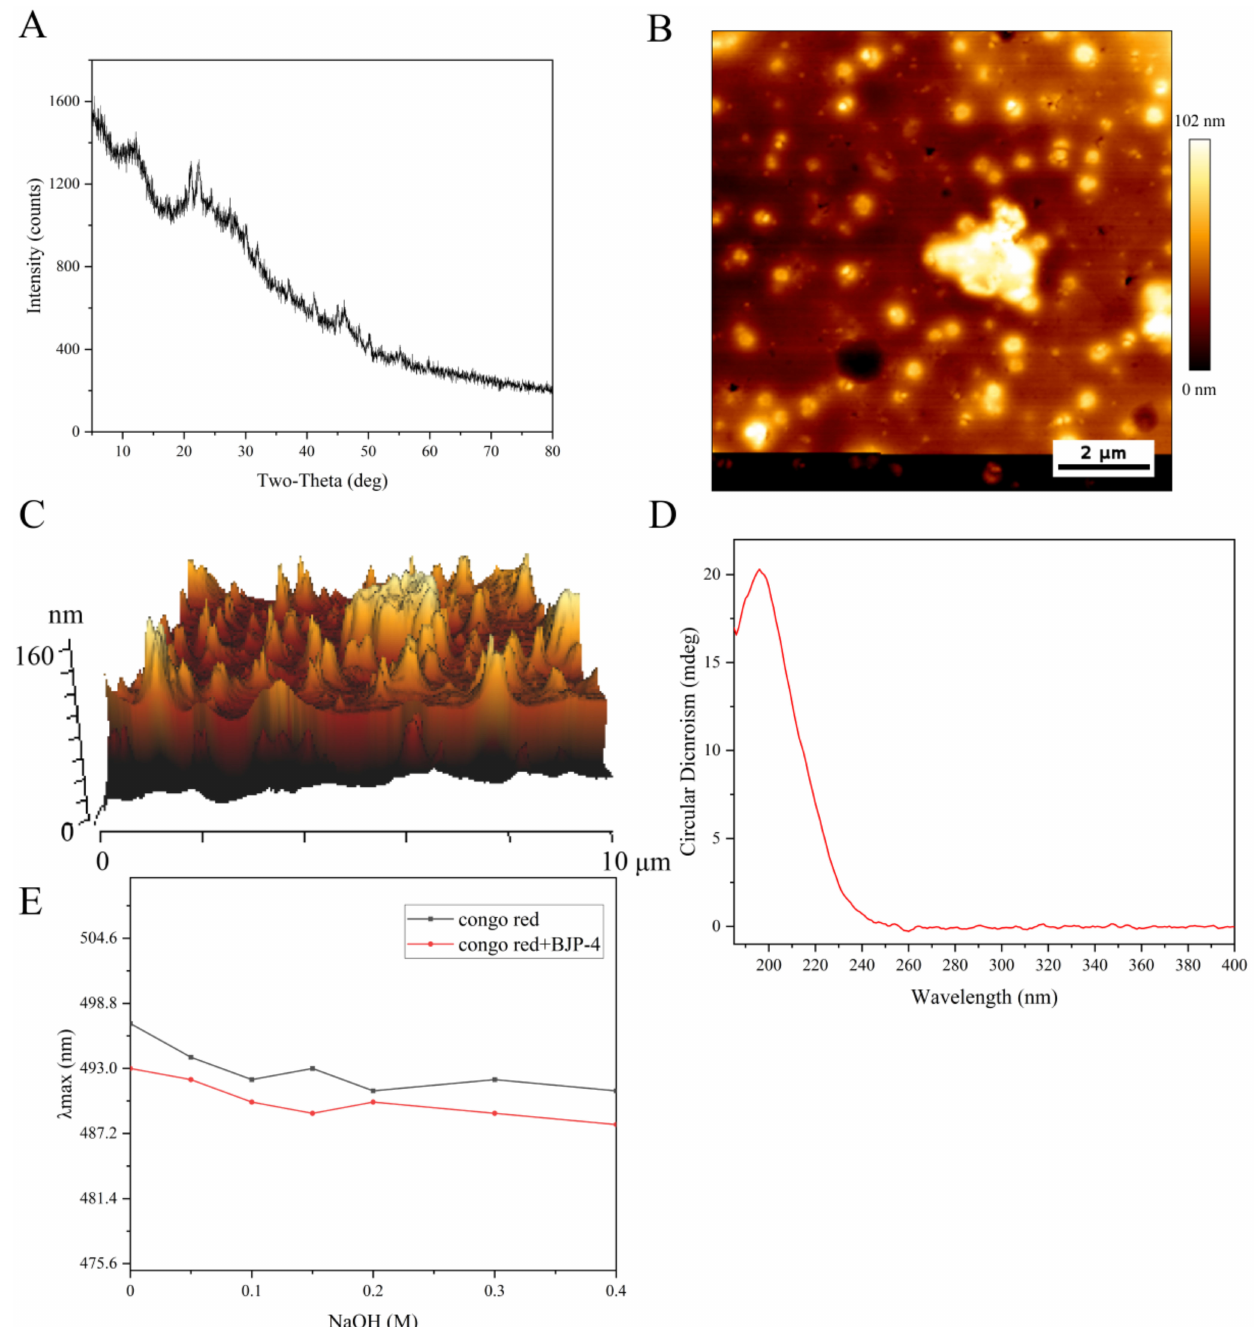
Figure 1. The chemical structure analysis of BJP-4: ( A ) X-ray diffraction pattern. ( B ) The atomic force microscope planar image. ( C ) Three-dimensional image of atomic force microscope. ( D ) Circular dichroism spectrum. ( E ) Effect of BJP-4 on the λ max of Congo